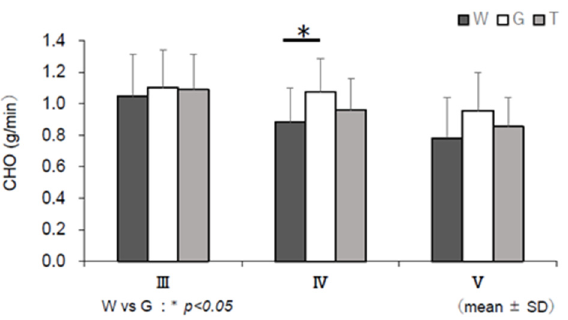
Figure 11. Glucose oxidation (CHO) assessments. W—water; G—glucose; T—trehalose. Comparison of CHO (g/min) in each trial (water (W), glucose (G), and trehalose (T)) in III, IV, and V ( n = 12). W vs. G: * p < 0.05.